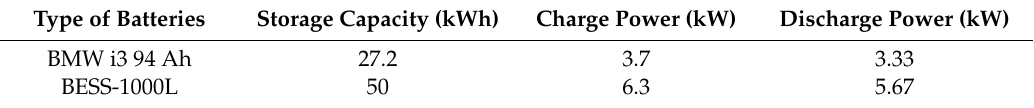
Table 2. Electric vehicle (EV) and as battery energy storage systems (BESS) specifications.